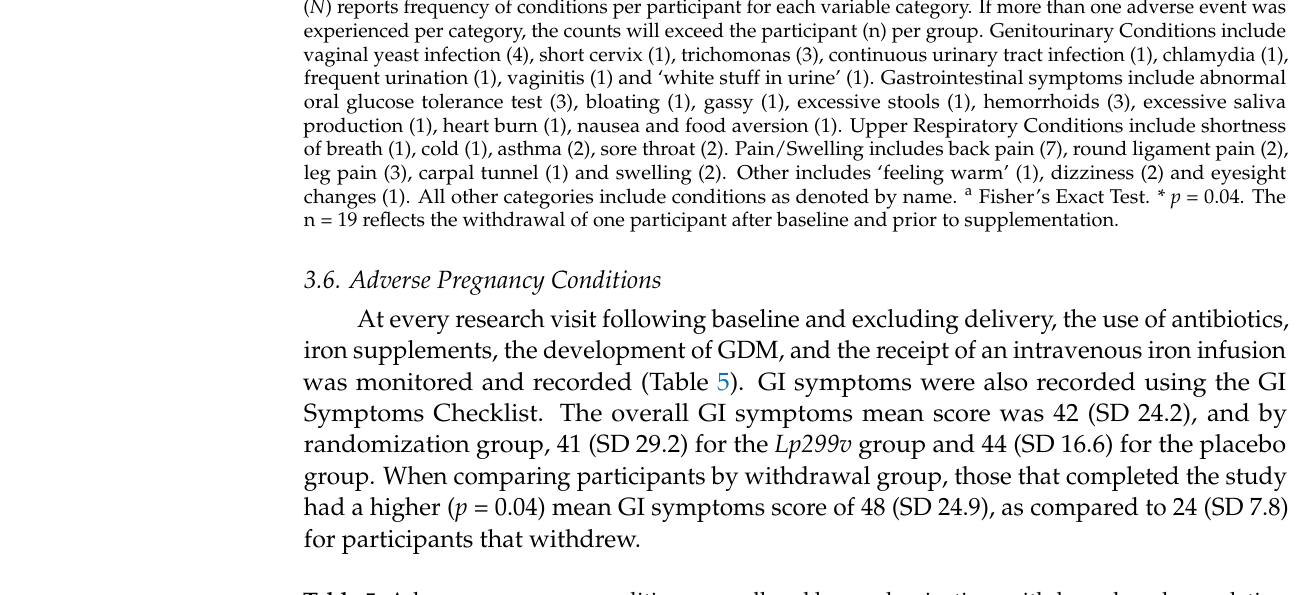
Table 5. Adverse pregnancy conditions overall and by randomization, withdrawal, and completion